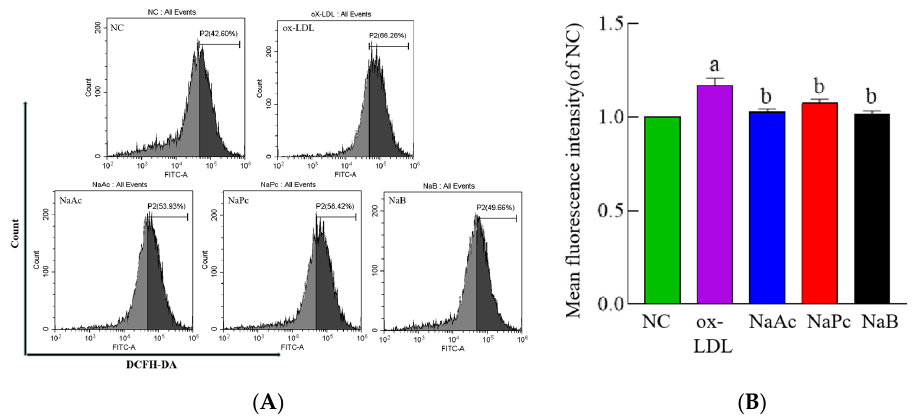
Figure 3. ROS production in THP-1 cells. The THP-1 cells were pre-treated with 50 mg/L ox-LDL for 24 h and then treated with 200 μ mol/L NaAc, NaPc, and NaB for 24 h. ROS production was determined by flow cytometry. ( A ) The histogram of flow cytometry analysis. ( B ) The production of three main short-chain fatty acids. a p < 0.05 vs. NC group. b p < 0.05 vs. ox-LDL group.